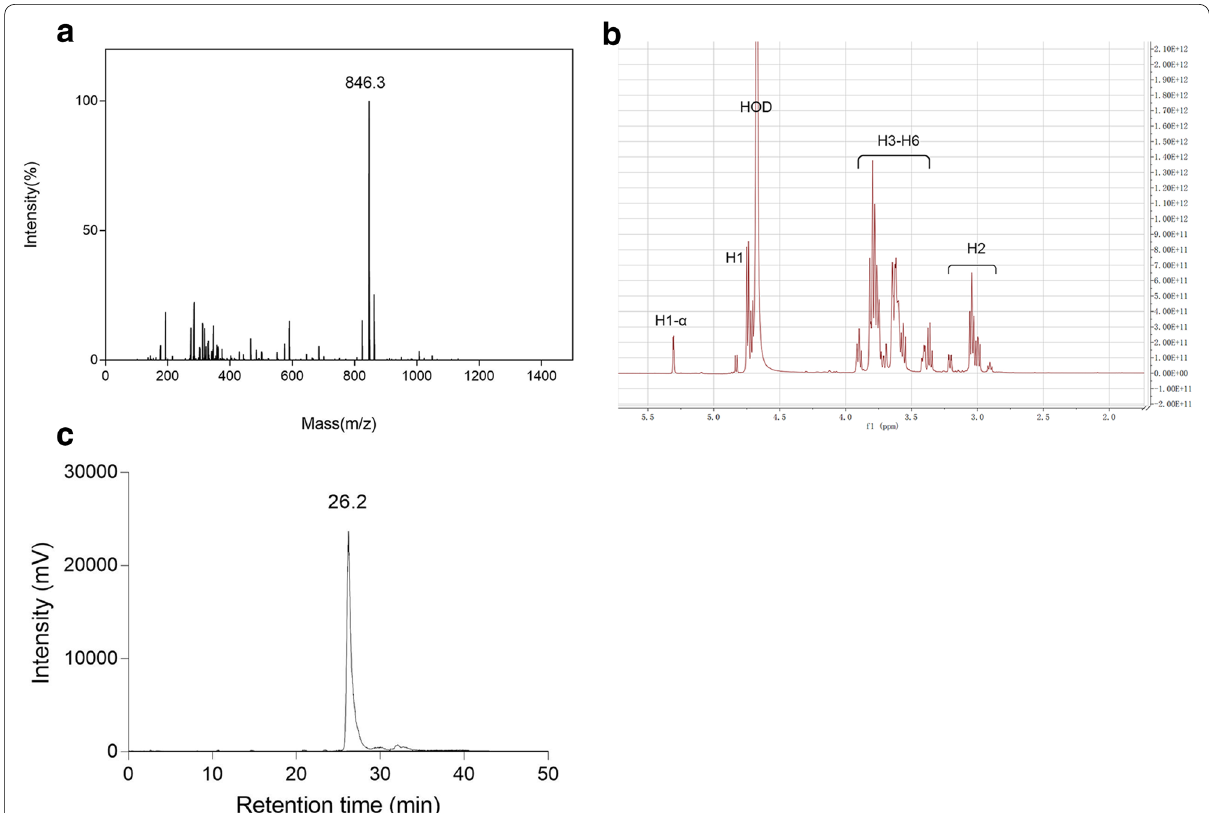
Fig. 1 Structural characterization of (GlcN) 5 . a MALDI-TOF-MASS spectrometry analysis of (GlcN) 5 . b 1 H NMR spectrometry analysis of (GlcN) 5 . c HPLC analysis of